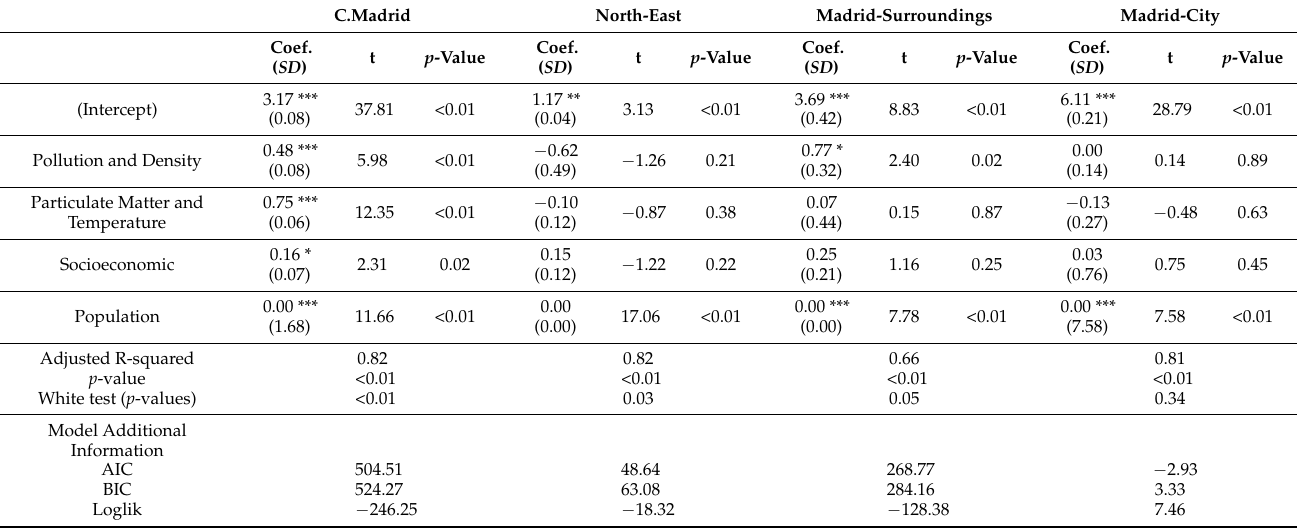
Table 4. Regression models with